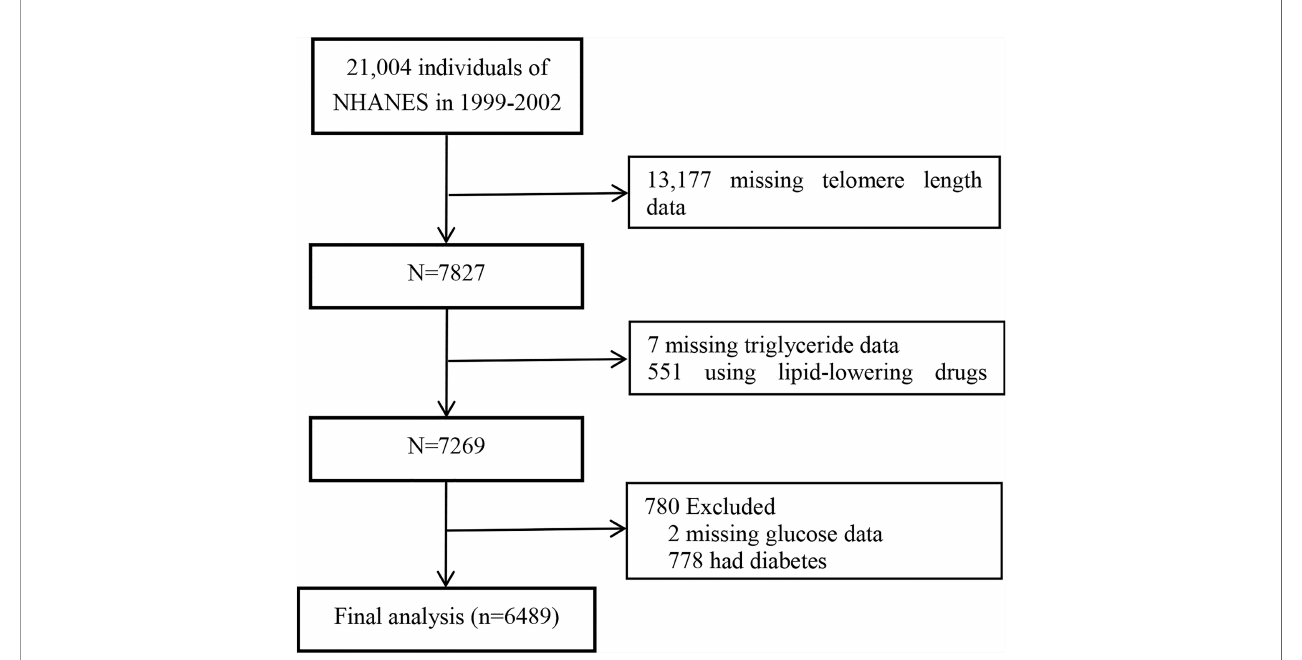
FIGURE 1 | Flow chart of study